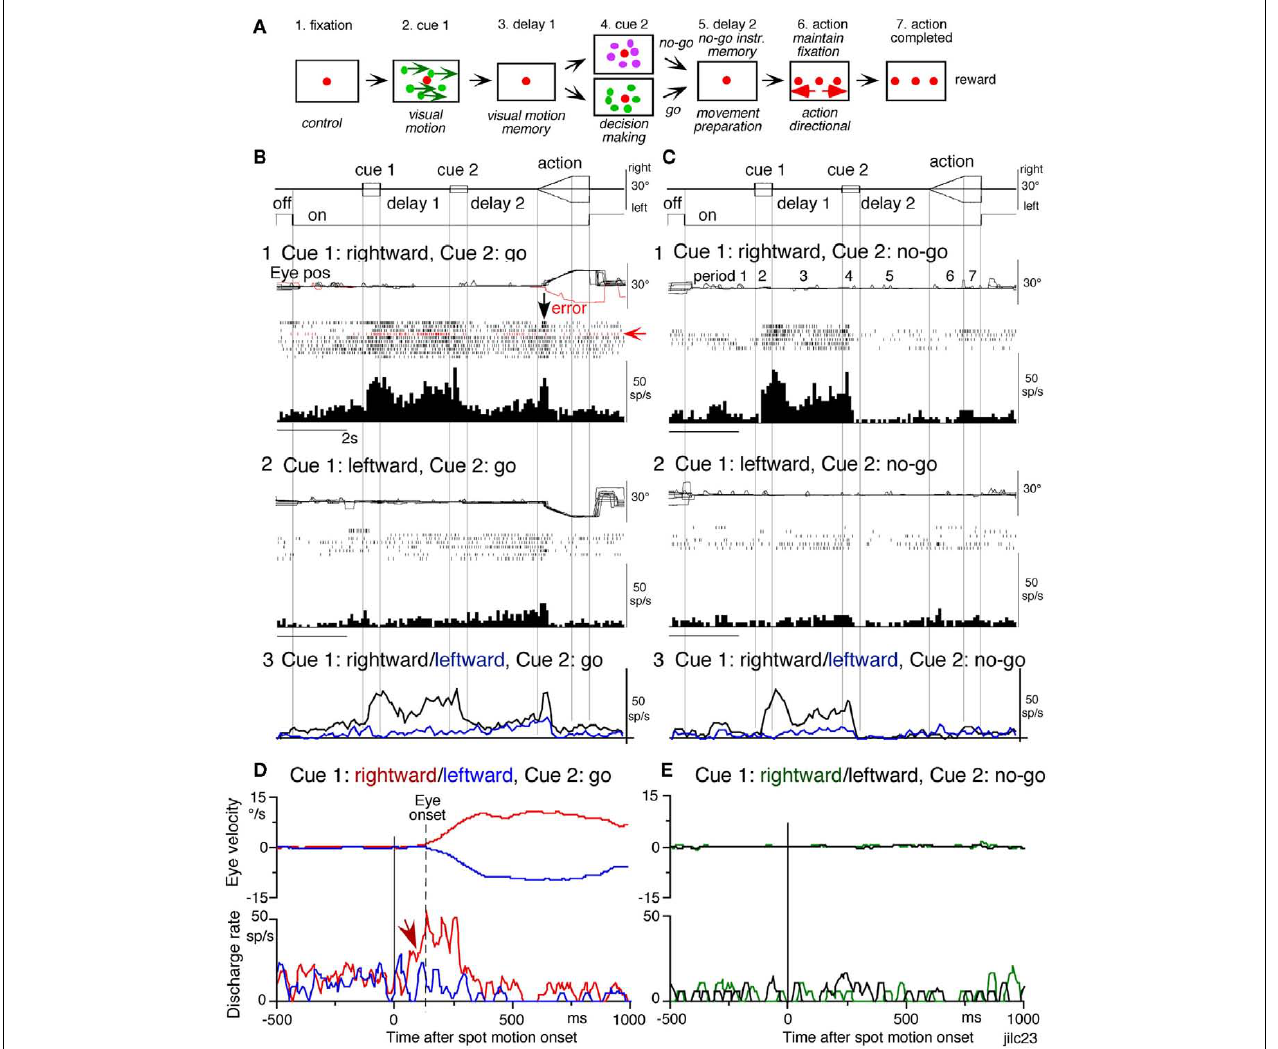
with the mean rate ( ± SD) during the initial fixation [ (C1) , period 1] for each neuron. Significant differences were defined as those having a p -value < 0.05 using Student’s t test with the Bonferroni correction for multiple comparisons. Neurons that exhibited significant modulation during this task were defined as task-related neurons. (D,E) De-saccaded and averaged eye velocity and discharge of this neuron 500ms before and 1000ms after spot motion onset (vertical straight line) during the action period. Smooth-pursuit onset is indicated by a dashed line. Only correct trials were averaged for go (D) and no-go conditions (E) as indicated by colors. See text for further explanation. Modified from Shichinohe et al. (2009) with